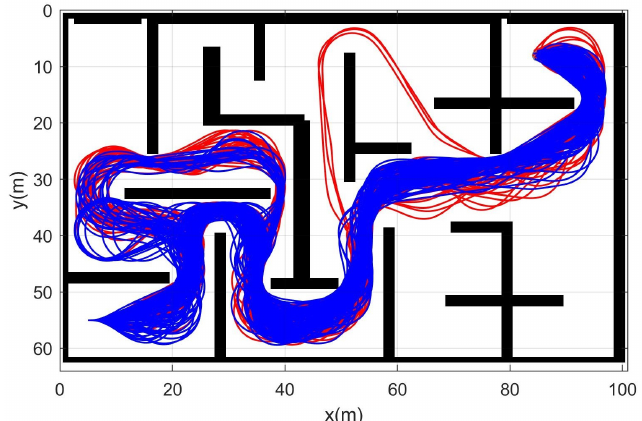
Figure 11. Resultant trajectories from simulation 5. Red lines: DT-RRT, Blue lines: